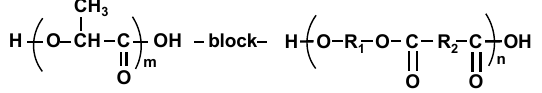
Figure 1. Chemical structural formula of polylactic acid (PLA).